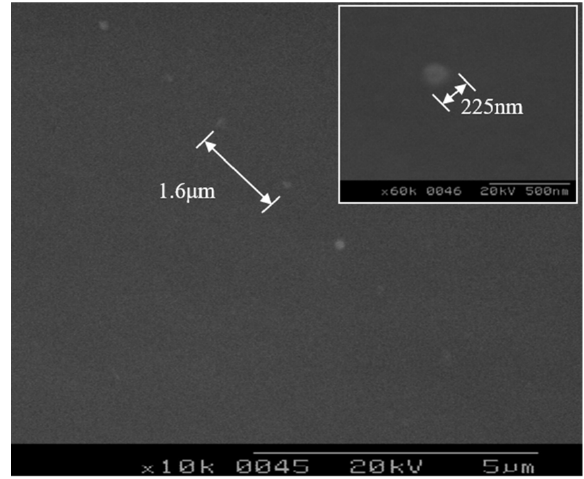
Figure 4. SEM images of the dots melted by incident laser pulses for a 30 μ m thick transfer film. An adequate dye concentration of 0.001 M yielded the optimal thermal energy absorption. The measured dot diameter was 225 nm, as shown in the inset.